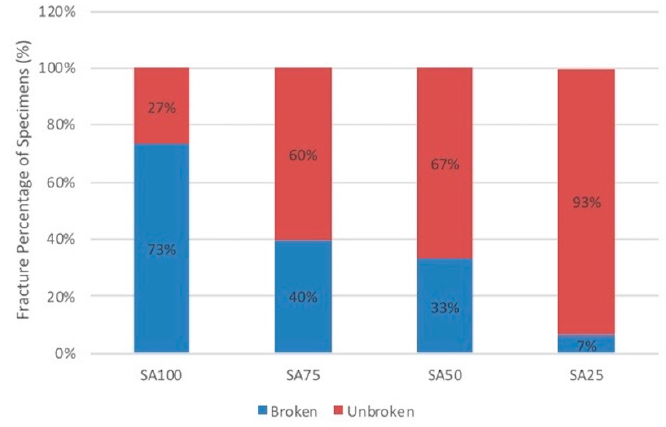
Figure 4. Histogram of results shows the percentage of broken and unbroken specimens corresponding to four types of abutment designs SA100, SA75, SA50, SA25 .